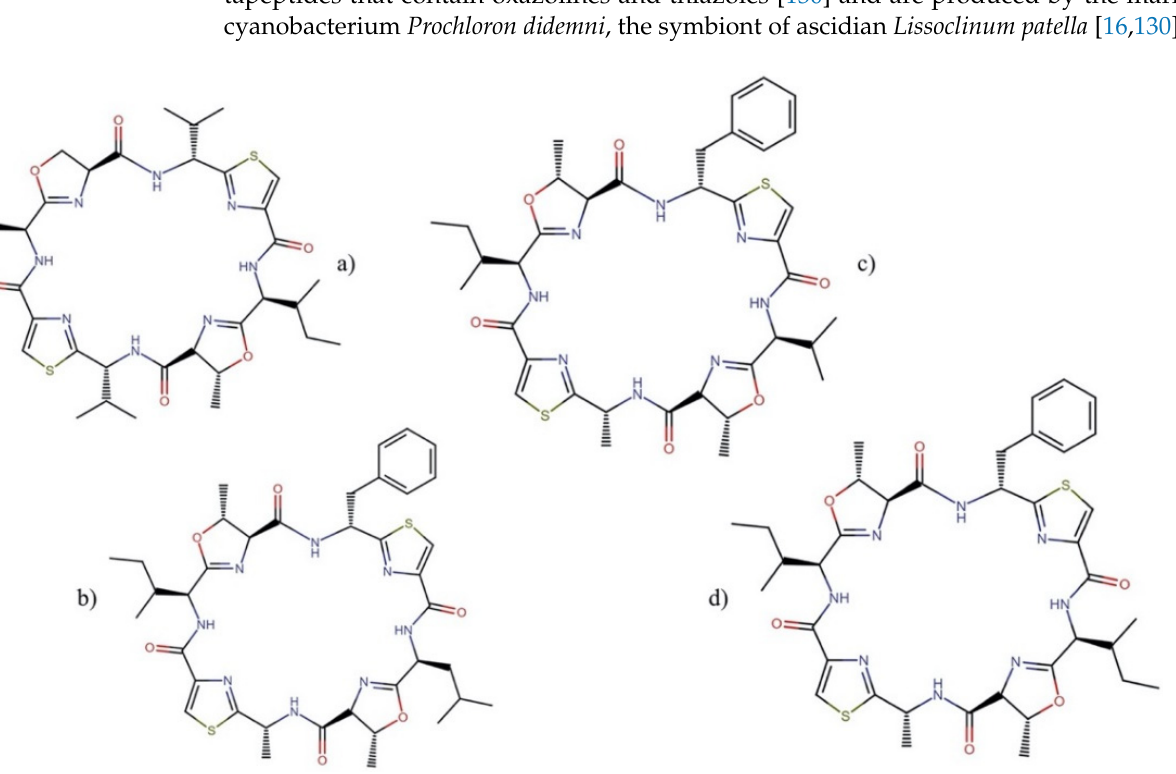
Figure 19. Chemical structures of the most representative patellamides: ( a ) patellamide A, ( b ) patel- lamide B, ( c ) patellamide C, and ( d ) patellamide D.